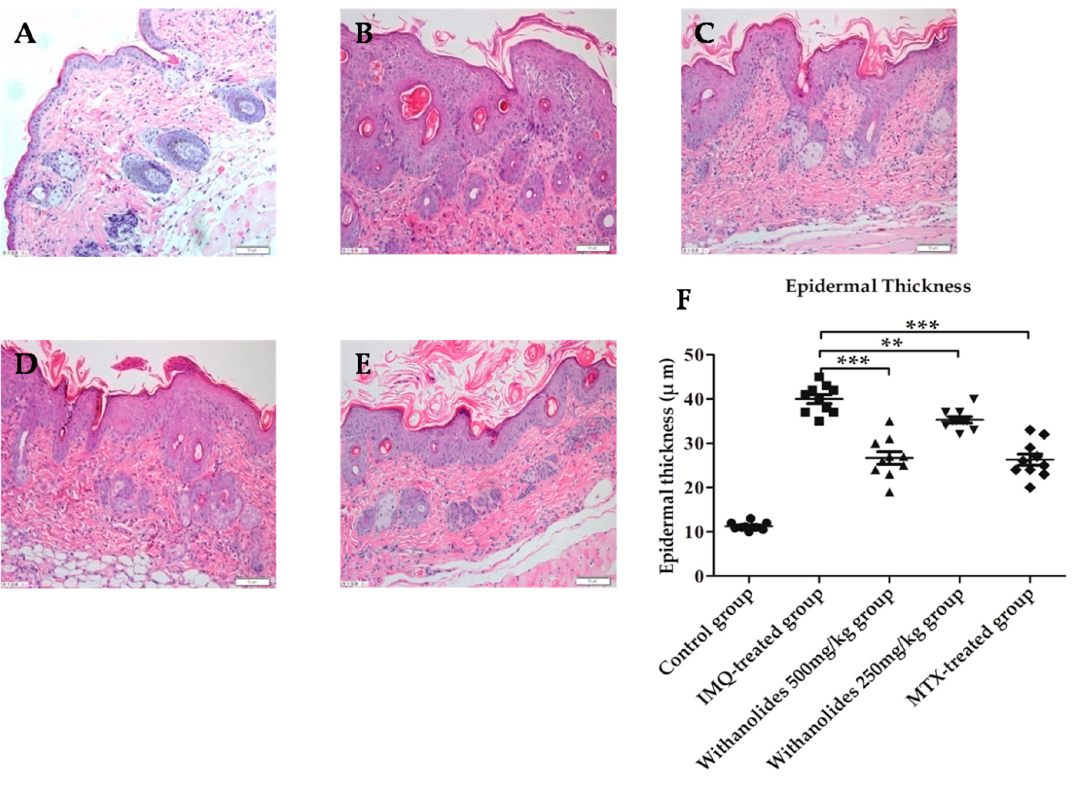
Figure 3. Effects of withanolides on histological changes in skin lesions of mice on day 6 of treatment (hematoxylin-eosin HE staining ×400. ( A ) Control group. ( B ) IMQ-treated group. ( C ) Withanolides 500 mg/kg group. ( D ) Withanolides 250 mg/kg group. ( E ) MTX-treated group. ( F ) Epidermal thickness in the dermis. Epidermal thickness in the dermis was measured in five randomly chosen fields (mean ± SD, n = 5). ** p < 0.01 vs. IMQ-treated group, *** p < 0.001 vs. IMQ-treated group.